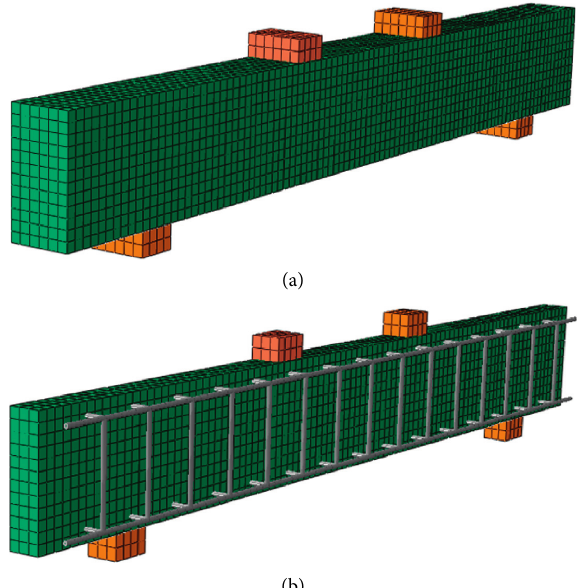
Figure 12: Finite element model in